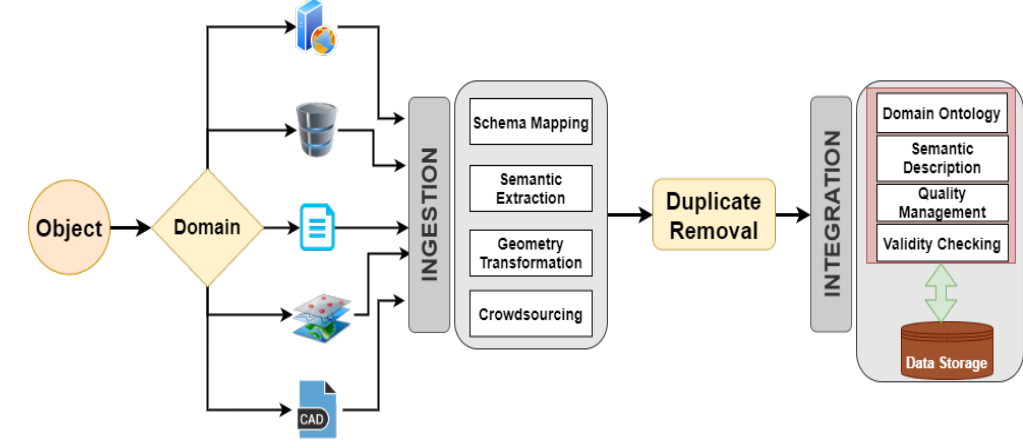
Figure 2. Paradigm of the data